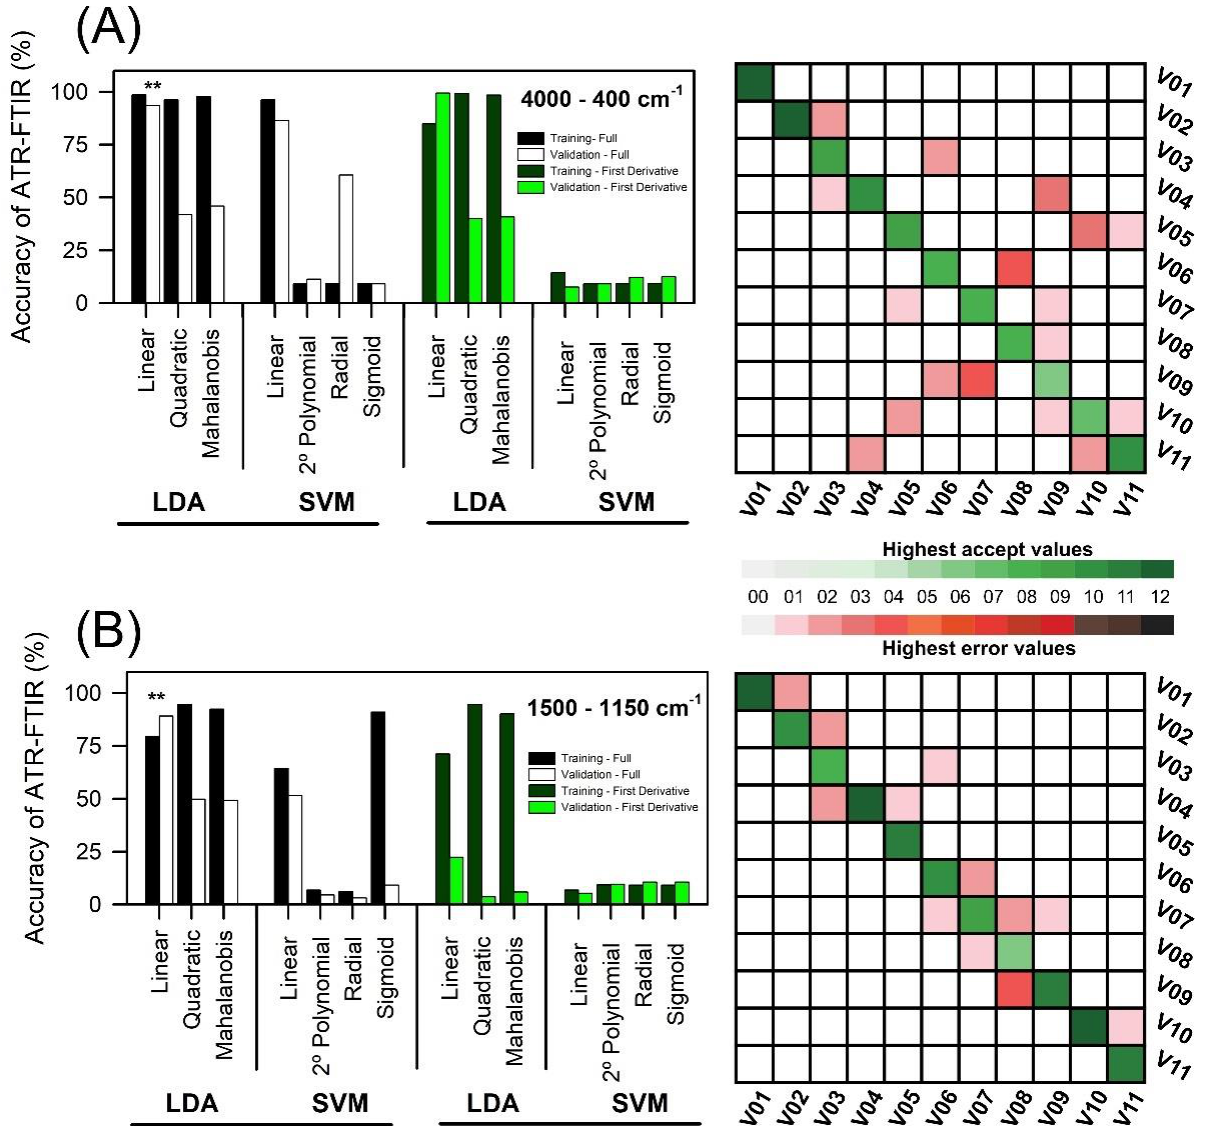
Figure 6. Accuracy of different machine learning algorithms based on linear discriminant analysis (LDA) and support vector machine classification (SVM) analyzed in full and transformed data (first derivative) on lettuce varieties ATR-FTIR spectroscopy data. ( A ) 4000 at 400 cm −1 . ( B ) 1500 at 1150 cm −1 . The first three PCA datasets were selected from the training and validation (testing) to create a confusion matrix for the machine learning algorithms, which showed higher overall accuracy. ** indicates the matrix confusion report on the right. The right boxes indicate the highest acceptance accuracy-precision, and the red boxes indicate the highest error accuracy-precision in the confusion matrix.